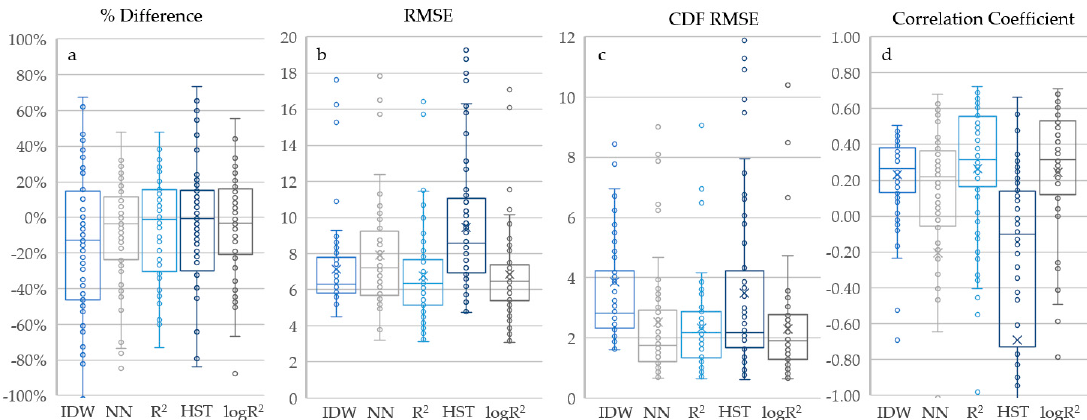
Figure 4. Results of the comparison between the filled-in data using different methods and the validation data, without applying the quantile mapping. In ( a ), the % difference in the mean is shown, in ( b ) the RMSE, ( c ) CDF RMSE and ( d ) Pearson’s r. Different colors serve only for artistic purposes.